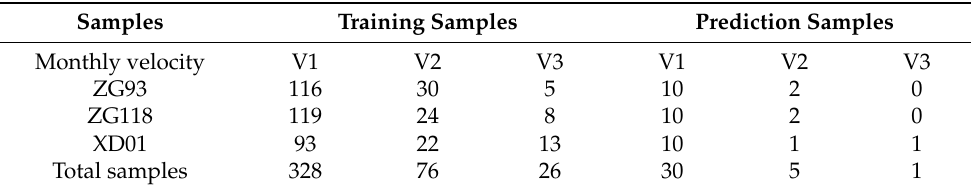
Table 6. Composition of training and prediction samples.